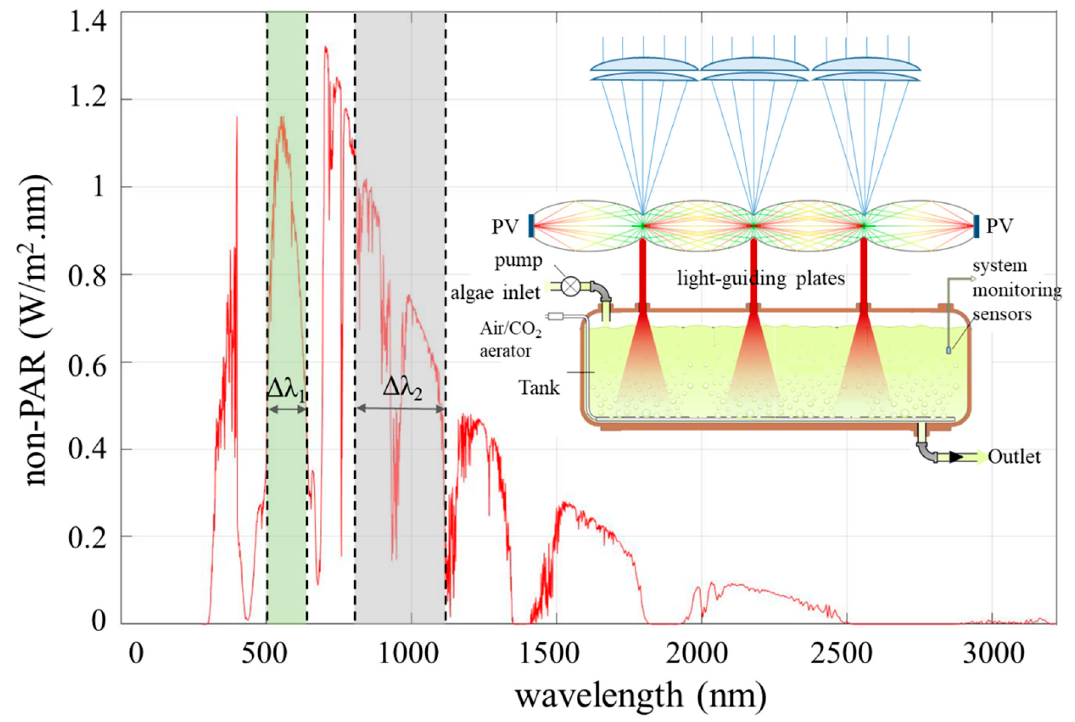
Figure 13. Green PAR and non-PAR from sunlight ( Δ W 1 = 500~600 nm and Δ W 2 = 740~1100 nm) can be absorbed in an EASSS in a tandem configuration with a PBR (inset). Blue and red PAR is transmitted through the EASSS and used to support algae cultivation in the PBR.